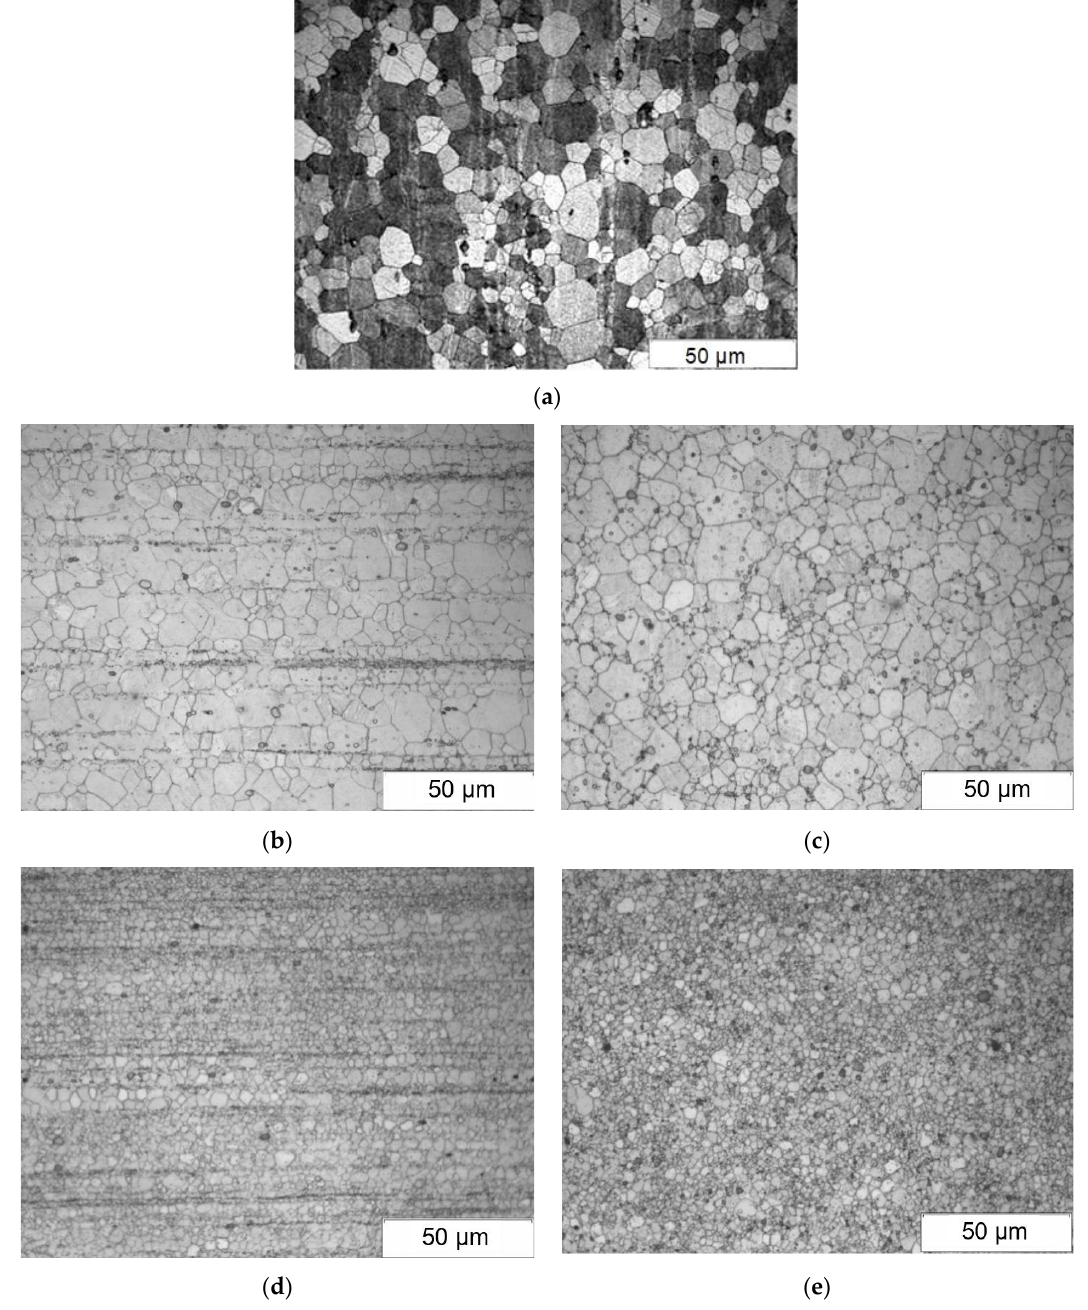
Figure 4. Microstructure of WE43 alloy after plastic deformation: ( a ) direct extrusion; ( b , c ) KoBo deformation, rod with diameter of 8 mm; ( d , e ) KoBo method extrusion, rod with diameter of 6 mm. The analysis of the microstructure after extrusion with the KoBo method showed the presence of a recrystallized structure. The analysis of the microstructure of the WE43 alloy after extrusion and KoBo extrusion revealed significant grain refinement. Precipitations observed in the microstructure of the WE43 alloy are located mainly on grain boundaries (Figure 4b) and form a band layout (Figure 4c). By comparison of the achieved microstruc- ture after the KoBo process with the microstructure after classic extrusion of the WE43 alloy, it can be concluded that there is significant fineness of structure present after applying